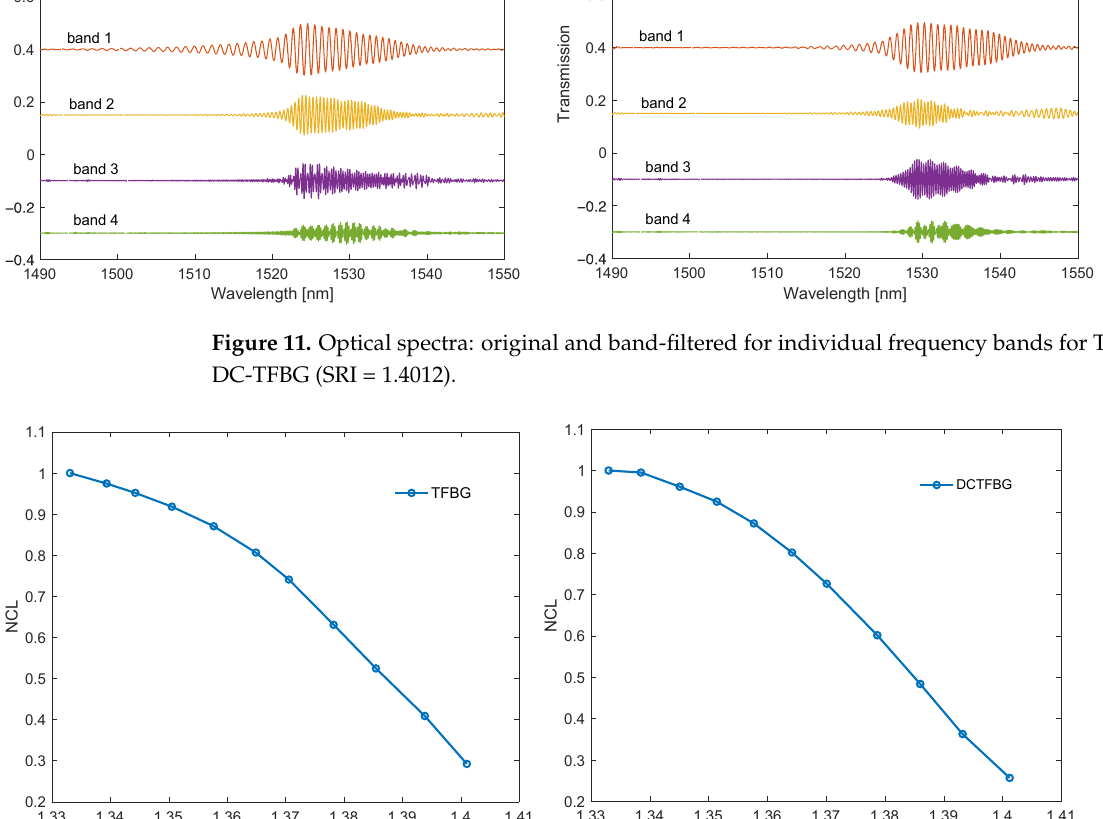
Figure 12. Change of the normalised contour length from SRI for the TFBG and DC-TFBG.